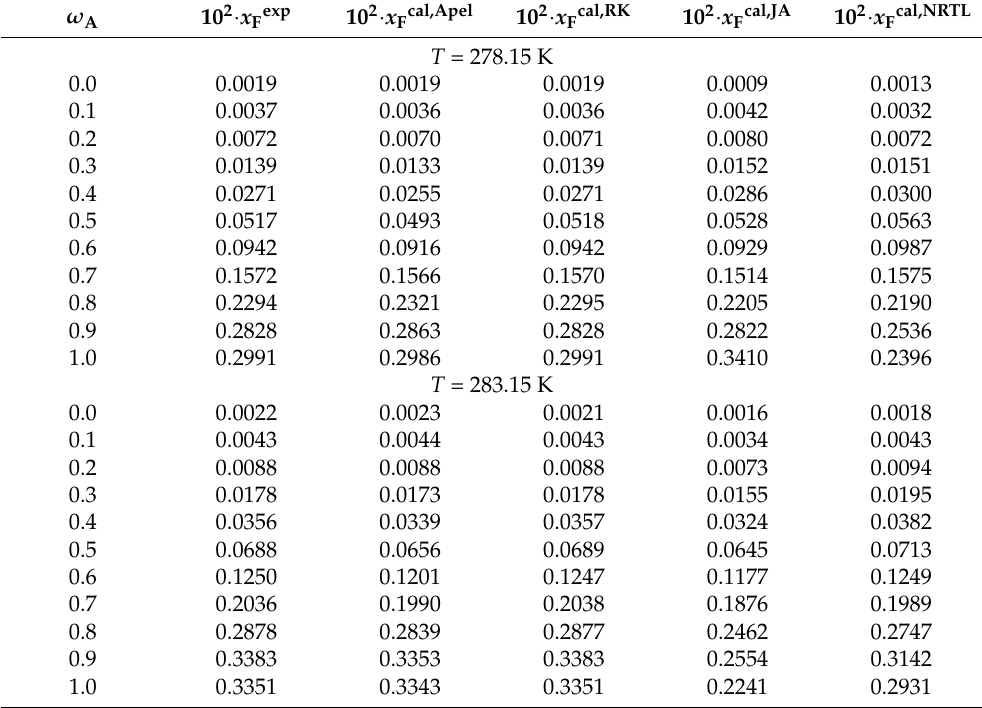
Table 2. Experimental and calculated molar ratio solubility of florfenicol in binary solvent mixtures of ethanol + water from T = 278.15 to 318.15